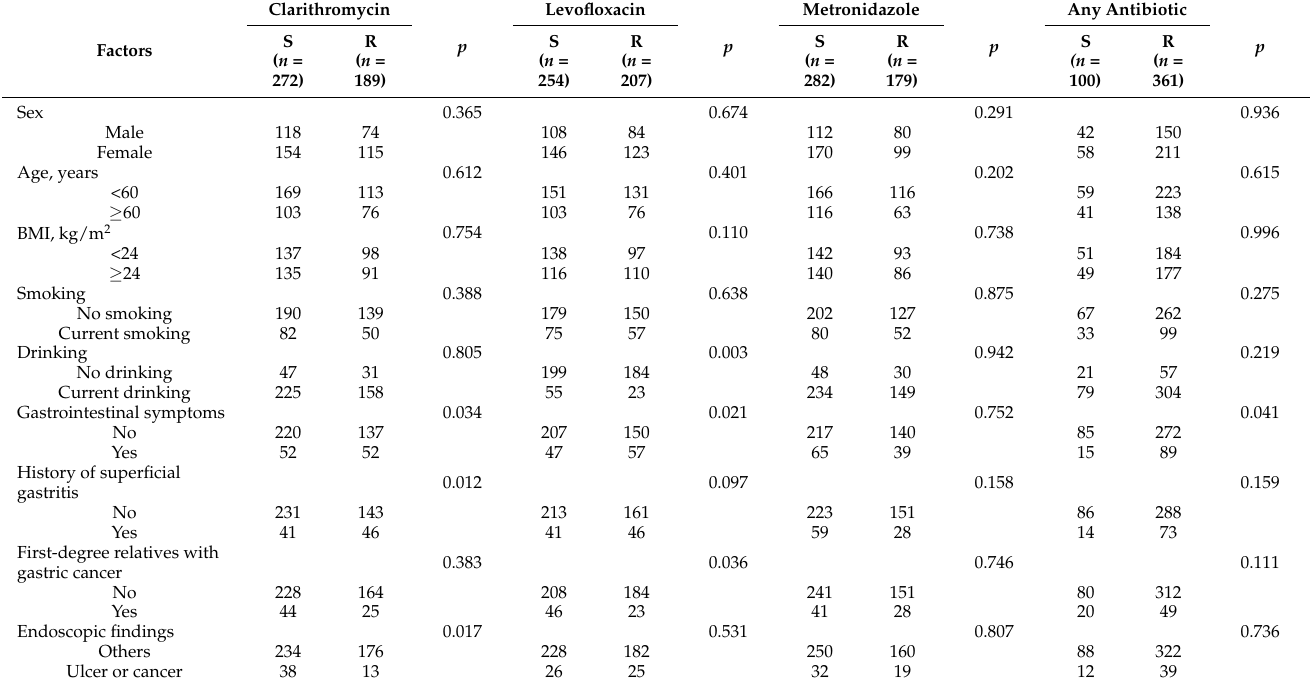
Table 5. Factors associated with the resistance of H. pylori to clarithromycin, levofloxacin, metronida- zole and any